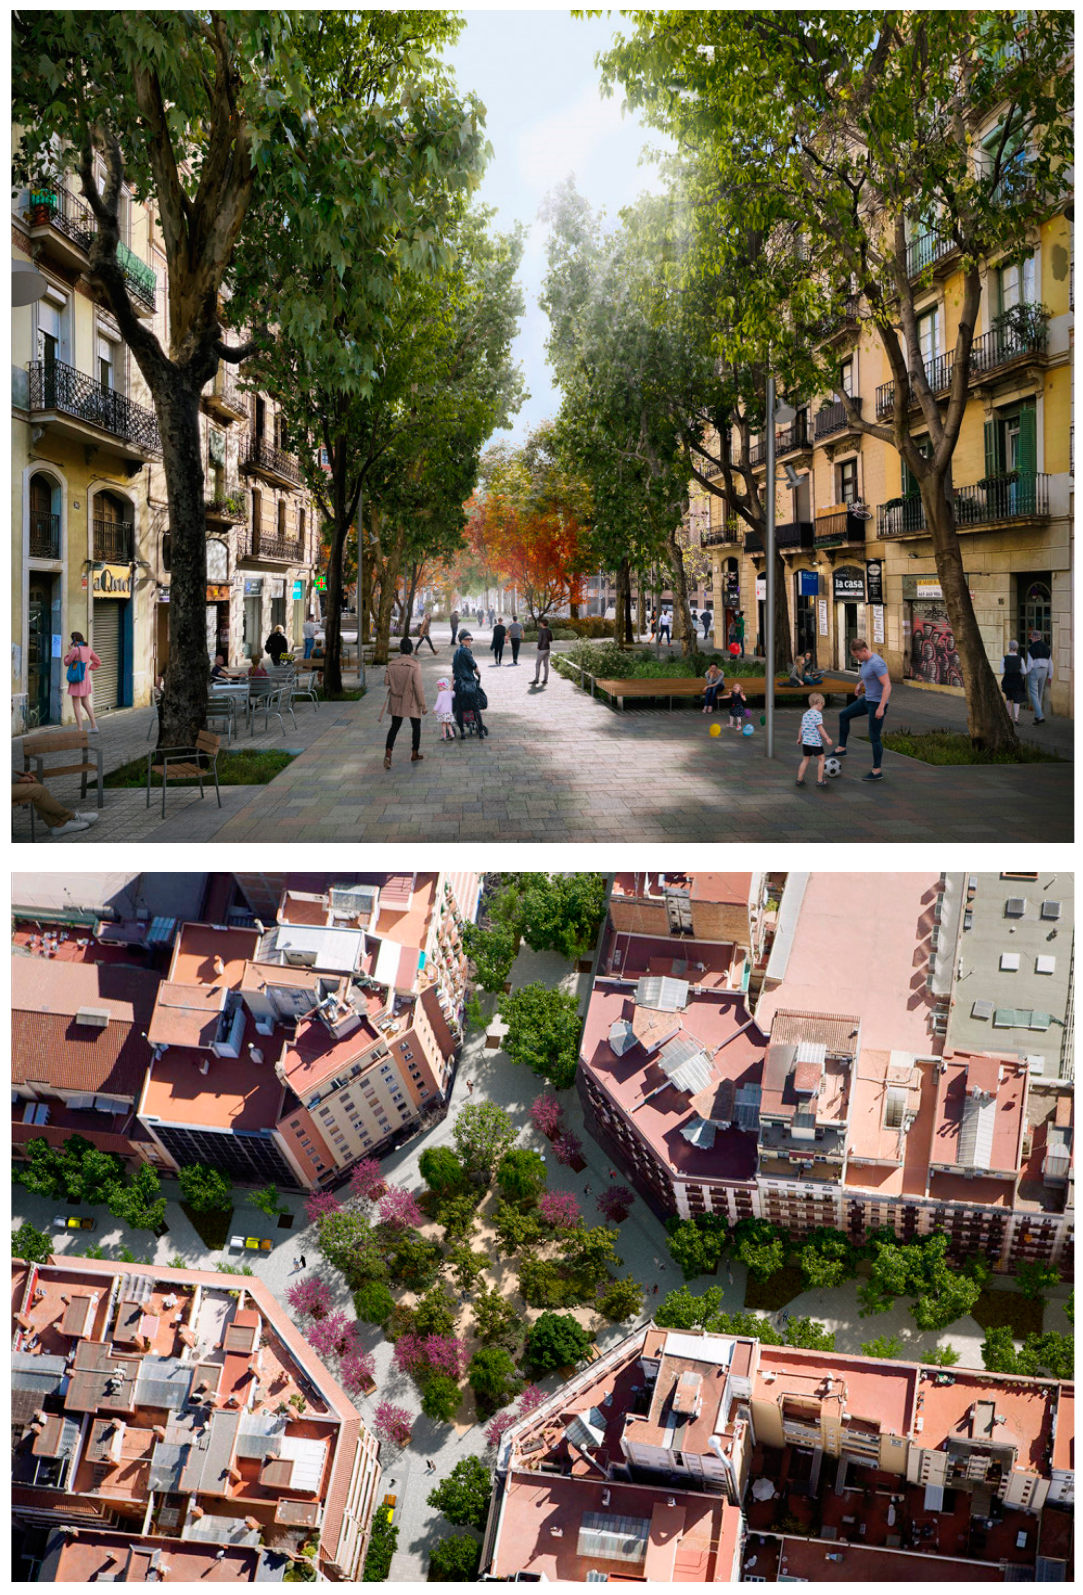
Figure 14. Images of the green axis project of Girona street ( top ) and square garden at the intersection between Consell de Cent and Rocafort ( bottom ). Source: Ajuntament de Barcelona [86].